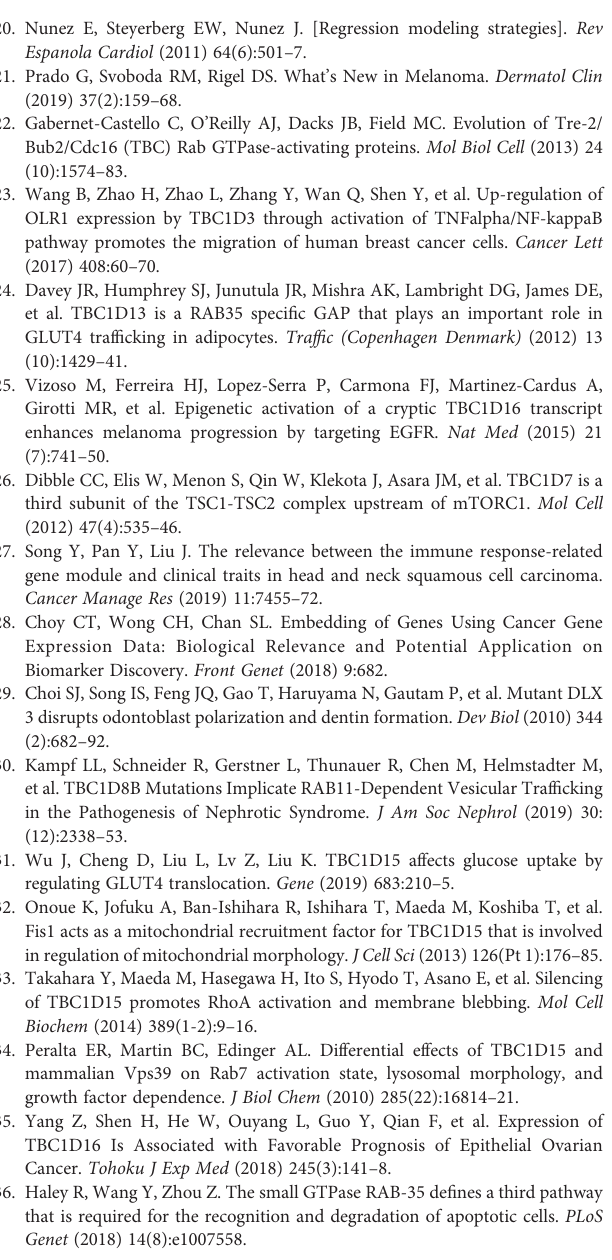
SUPPLEMENTARY FIGURE 3 | Protein expression of TBCs detecting by immunohistochemical assay based on online websites. Immunohistochemical staining showed the images of the protein expression of TBC1D10C (A) , TBC1D19 (B) , TBC1D16 (C) , and TBC1D13 (D) in normal skin tissues and melanoma tissues from the Human Protein Atlas website (www.proteinatlas.org). SUPPLEMENTARY FIGURE 4 | Survival analyses based on risk score and clusters. (A) Kaplan ± Meier survival analyses demonstrated the differences in OS, PFI and DSS based on risk scores (High vs Low) in primary tissues from TCGA. (B) Kaplan ± Meier survival analyses demonstrated the